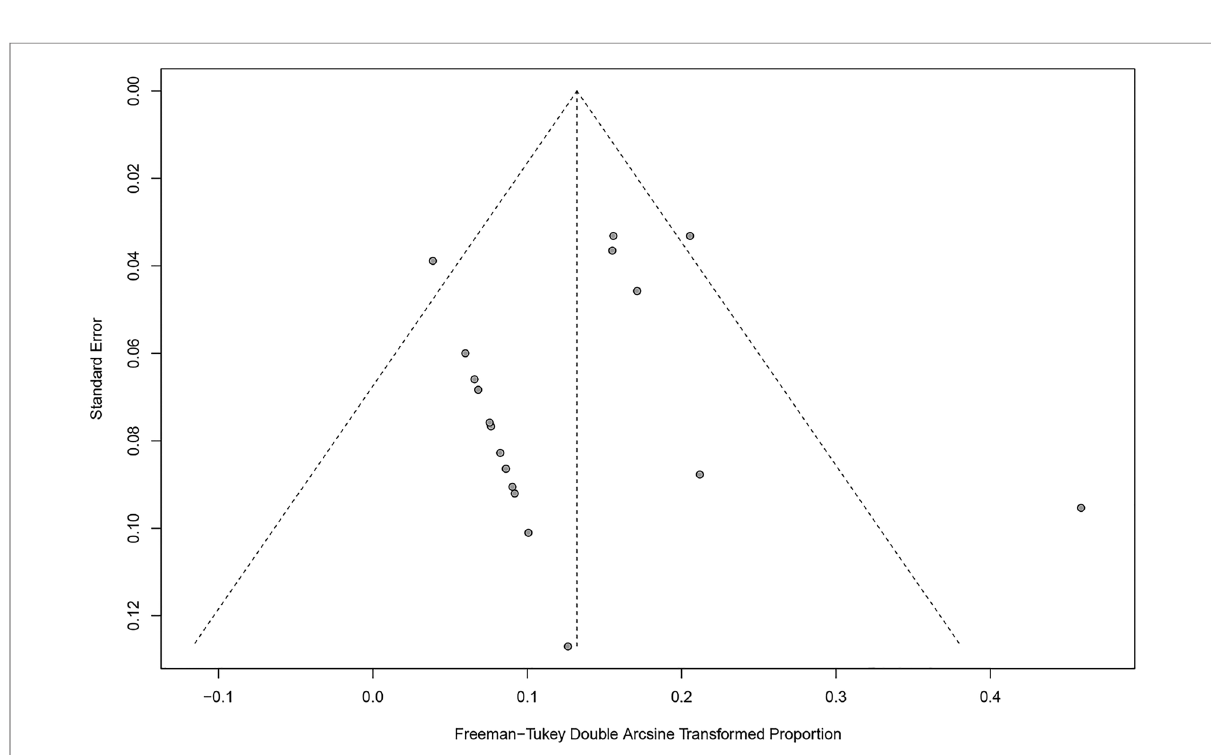
FIGURE 3 Funnel plot for the re-revision rate of retained stems for aseptic